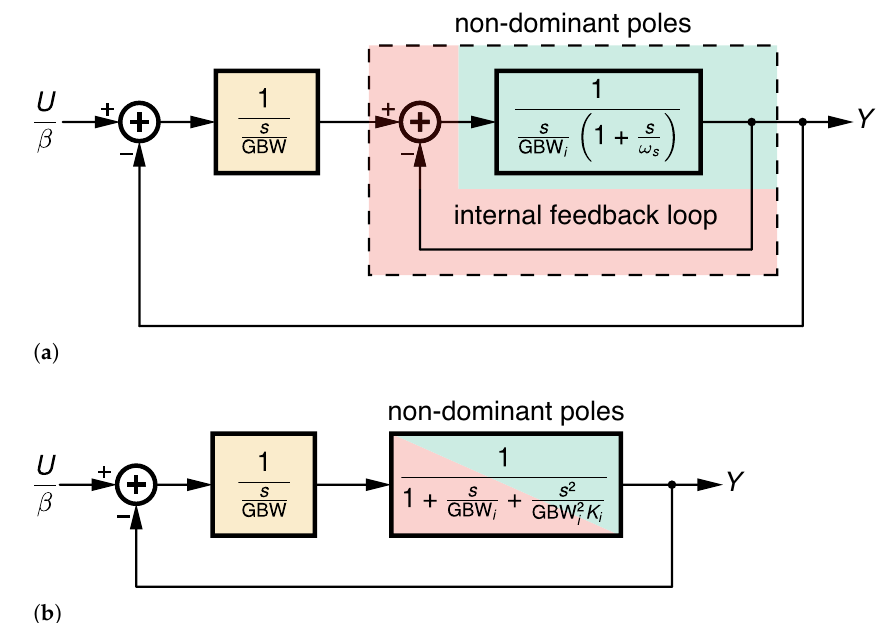
Figure 1. Block schematic modeling of a pure three-pole amplifier. ( a ) The non-dominant poles are due to an inner amplification stage fed back by a local loop. ( b ) The transfer function that models the non-dominant poles is that of a closed-loop feedback